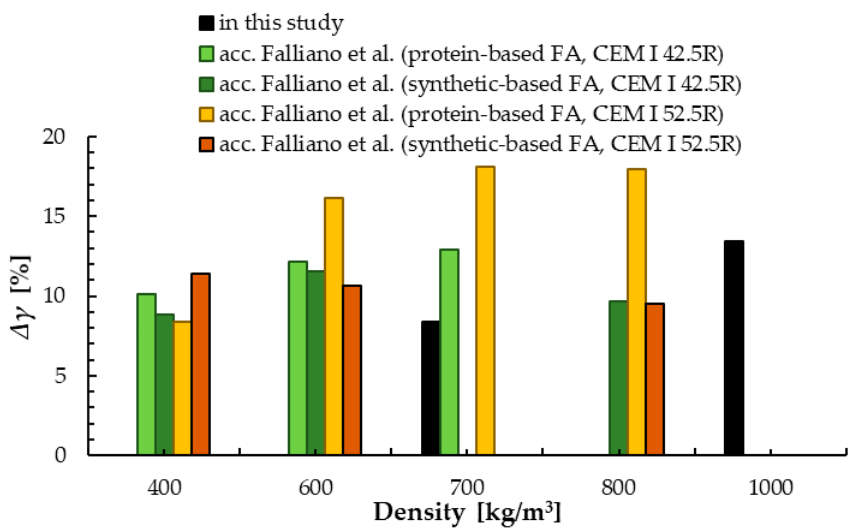
Figure 4. Ratio of difference between the density of the mixture and hardened foamed concrete to the density of hardened samples Δ γ depending on density.